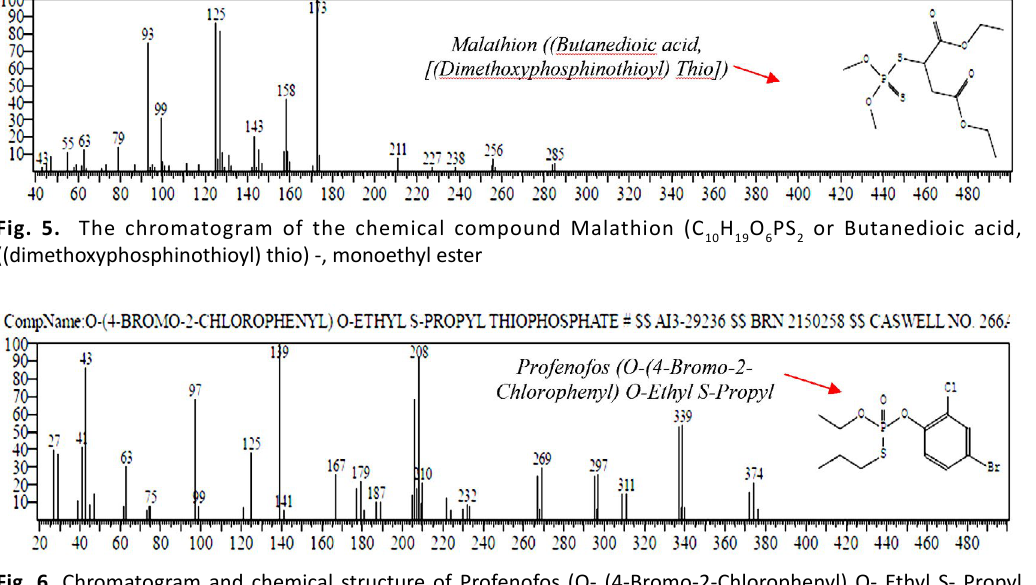
Fig. 6. Chromatogram and chemical structure of Profenofos (O- (4-Bromo-2-Chlorophenyl) O- Ethyl S- Propyl